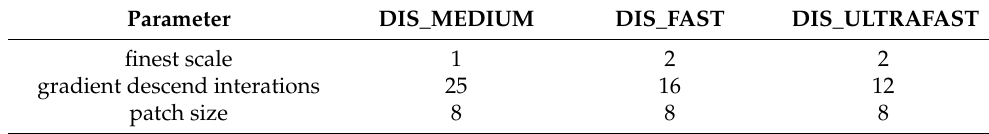
Table 1. Dense Inverse Search predefined parameters values.